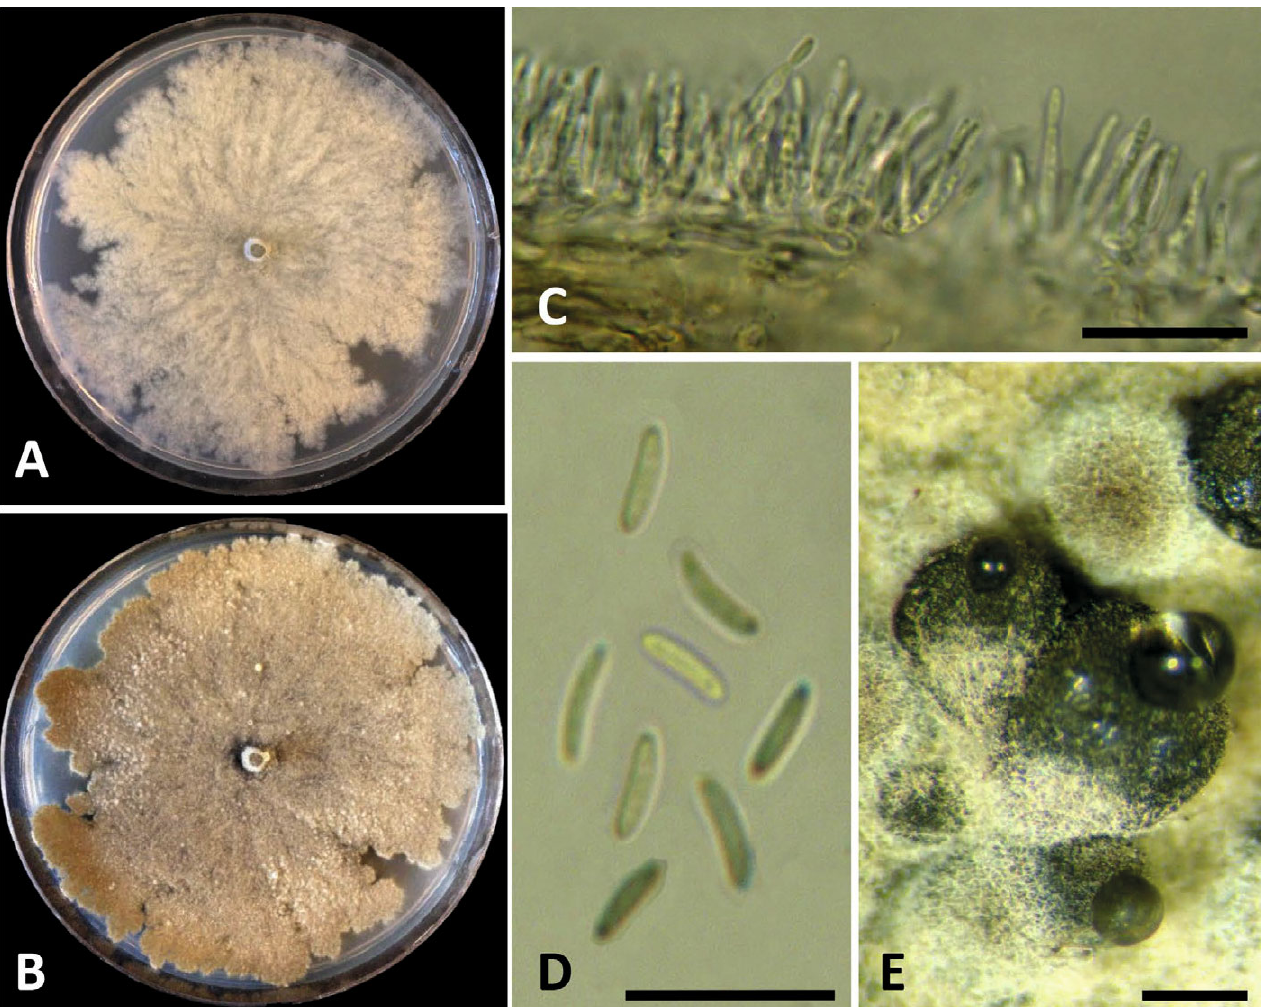
Fig. 16. Cytospora plurivora (ex-holotype culture CBS 144239). A. Seven-day-old PDA culture. B. Fourteen-day-old PDA culture. C.